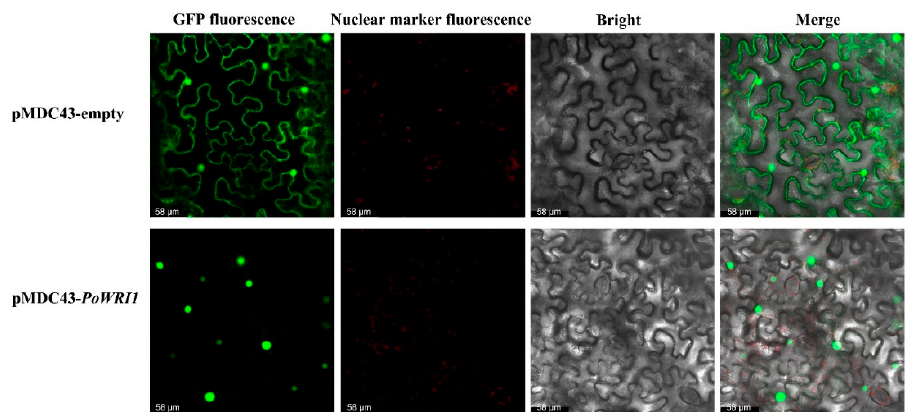
Figure 4. Subcellular localization of the PoWRI1 protein. An empty vector pMDC43 and pMDC43- PoWRI1 transiently expressed in N. benthamiana leaves. Bars = 58 μ m.